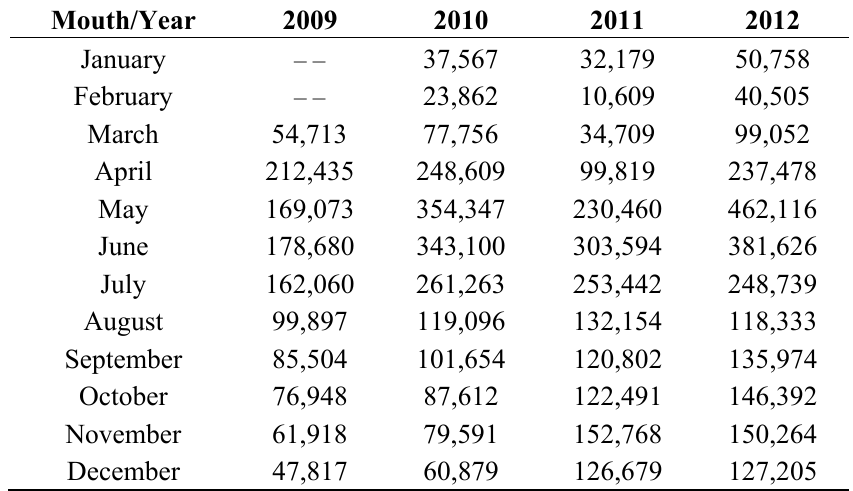
Table 1. The number of the HFMD patients reported every